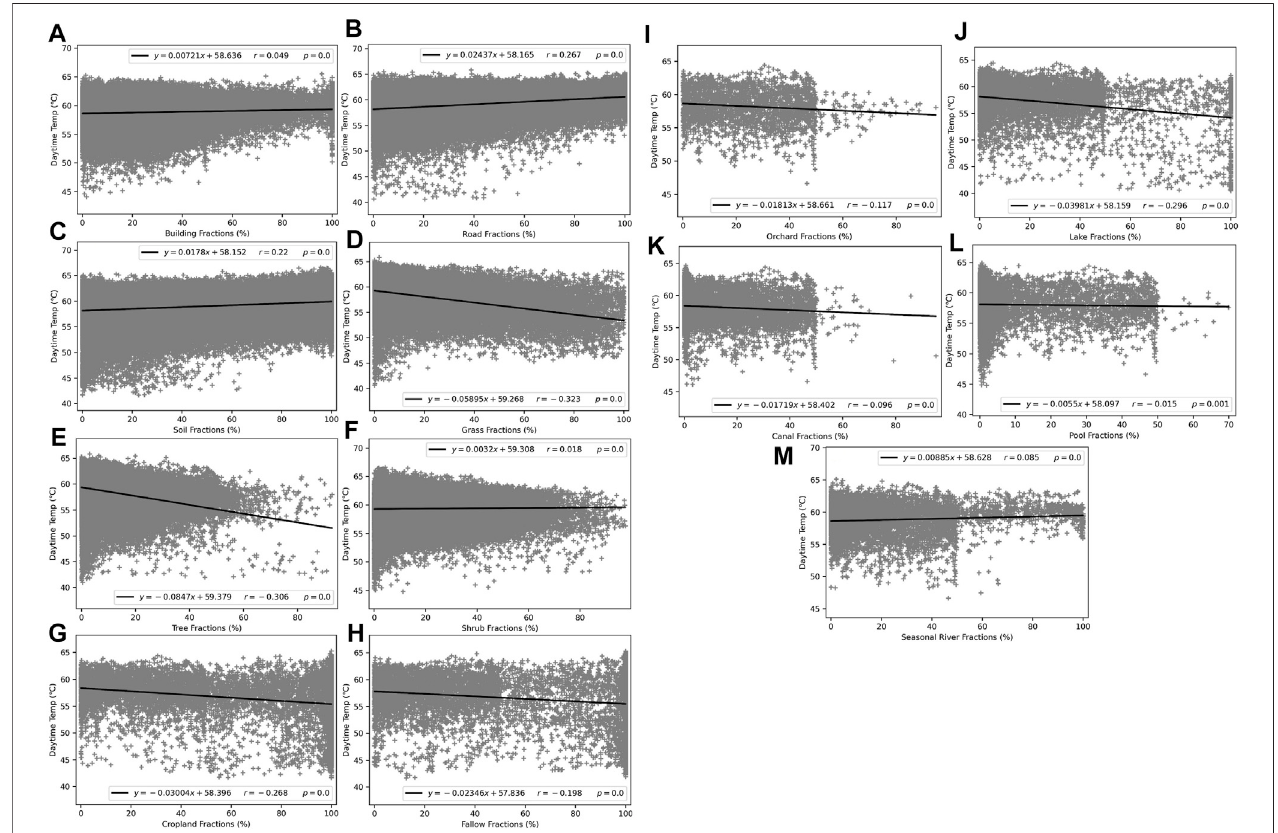
FIGURE 4 | Relationships between summer daytime LST and LULC fractions in Phoenix including the percent cover of (A) road, (B) building, (C) active cropland, (D) orchard, (E) fallow, (F) shrub, (G) tree, (H) grass, (I) unmanaged soil, (J) permanent river, (K) canal, (L) seasonal river, and (M) swimming pool, determined by linear